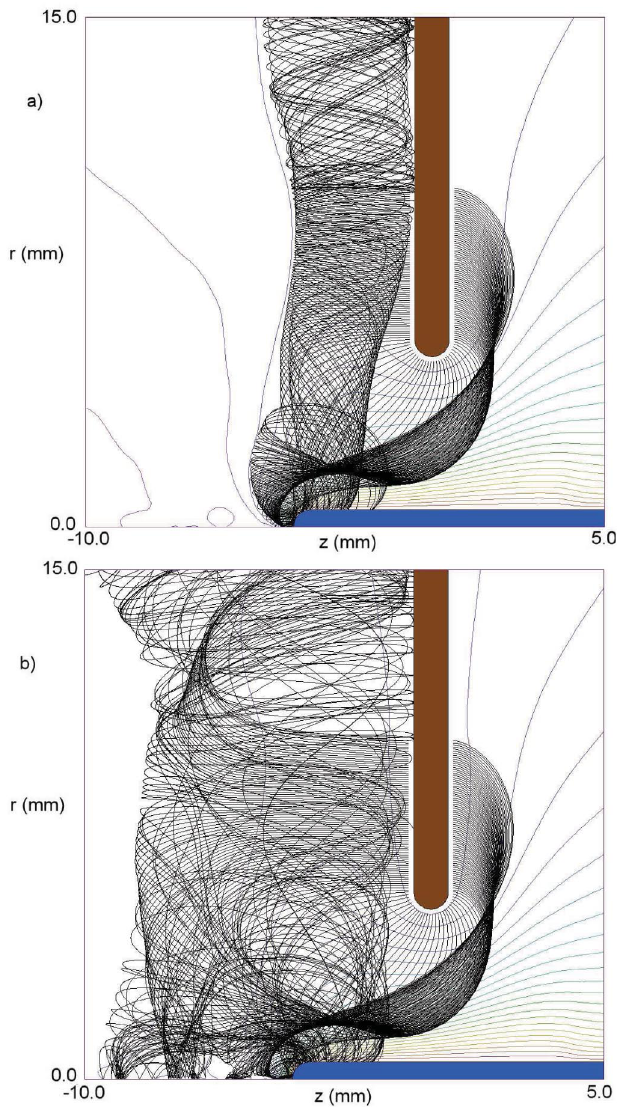
FIG. 7. (Color) Electron flow in the generic rod-pinch diode. (a) Cycle 68. (b) Cycle